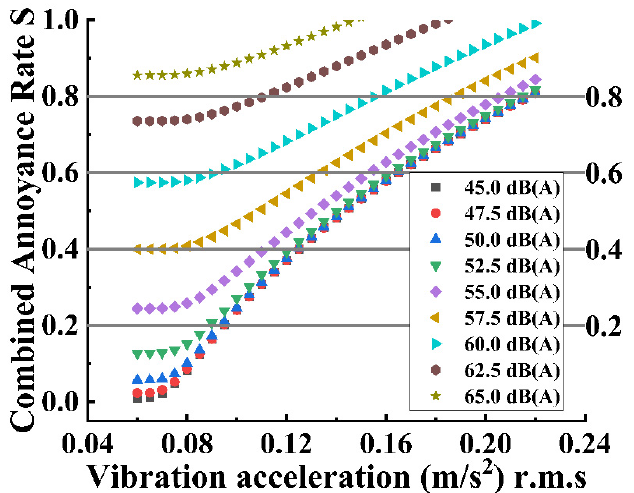
Figure 4. Influence of the vibration level on the assessment of noise.